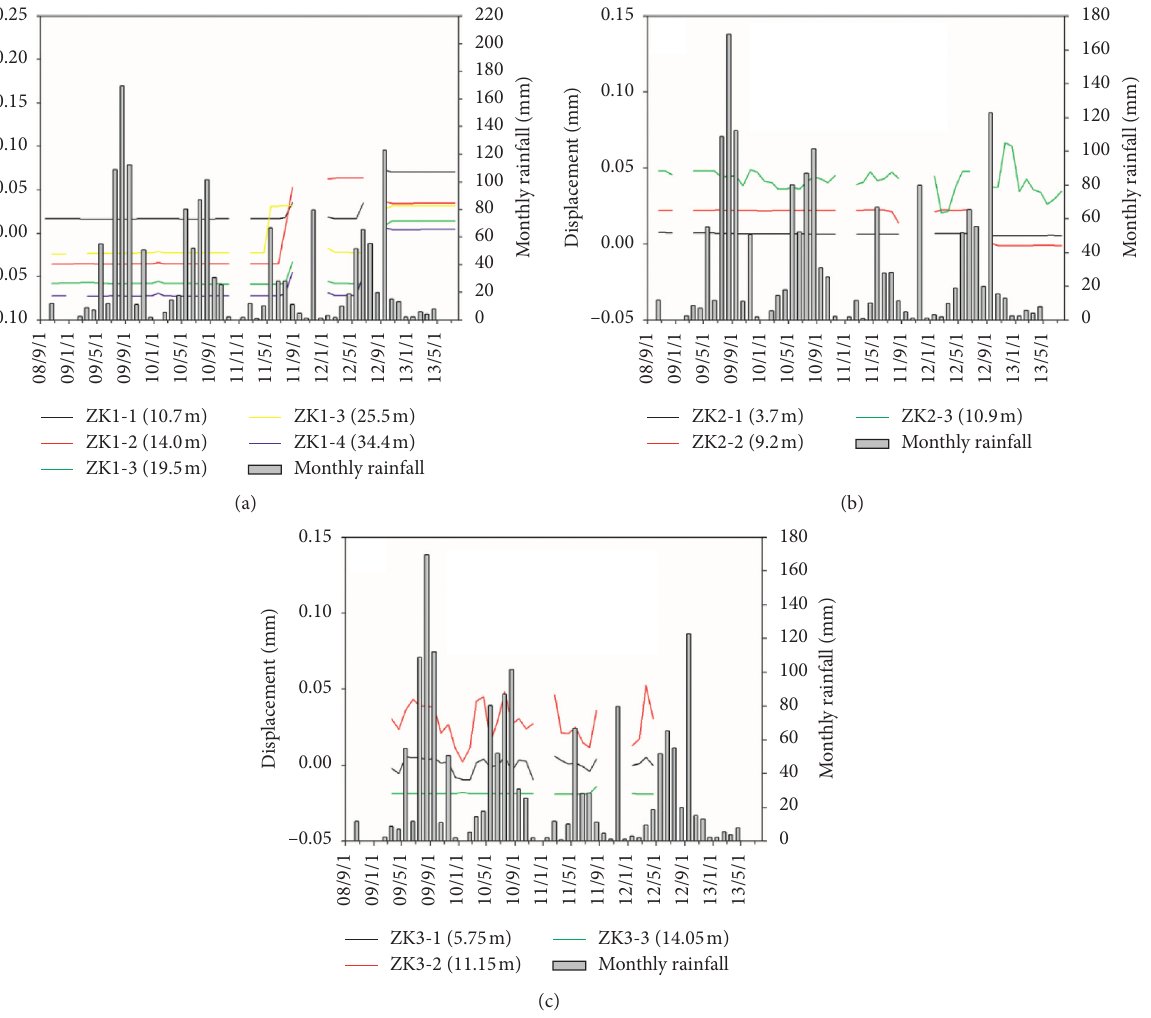
Figure 11: Relationship between monthly landslide displacement and monthly rainfall: (a) ZK1; (b) ZK2; (c)